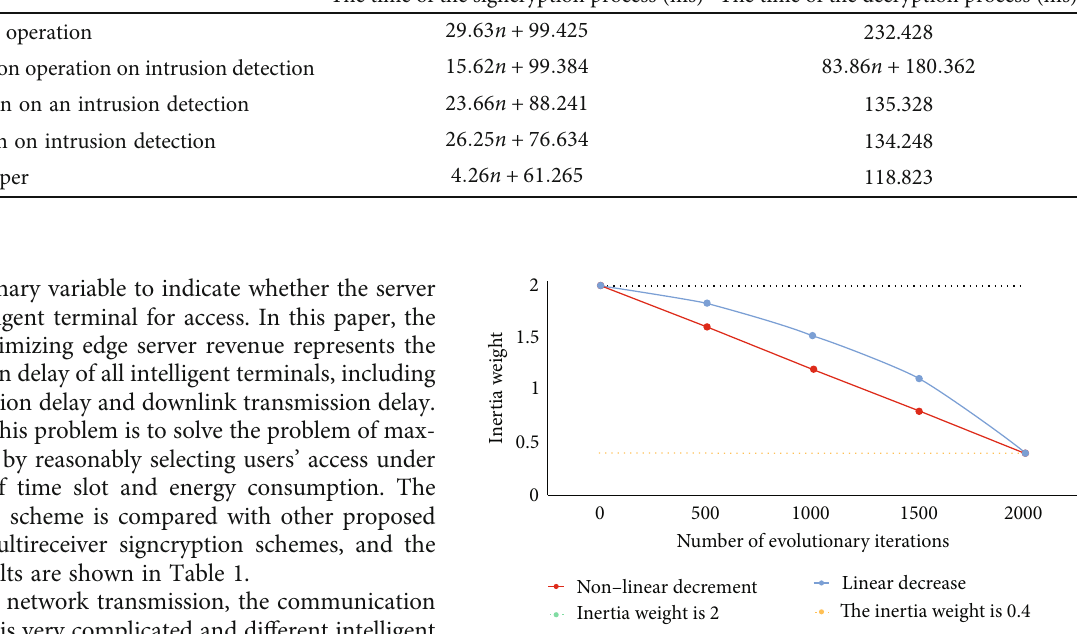
Figure 5: Scheme changes of di ff erent inertia weights.